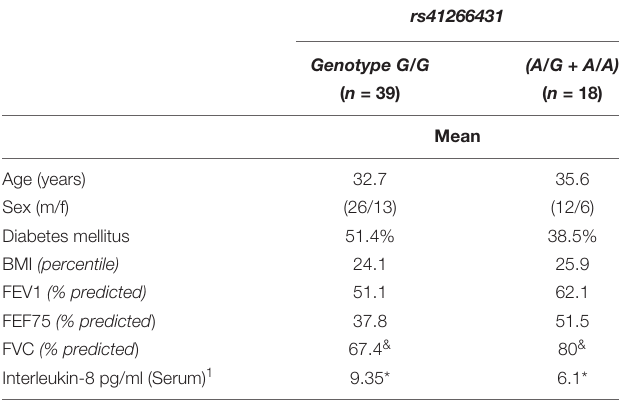
TABLE 4 | Characteristics of patients with chronic P. aeruginosa colonization.